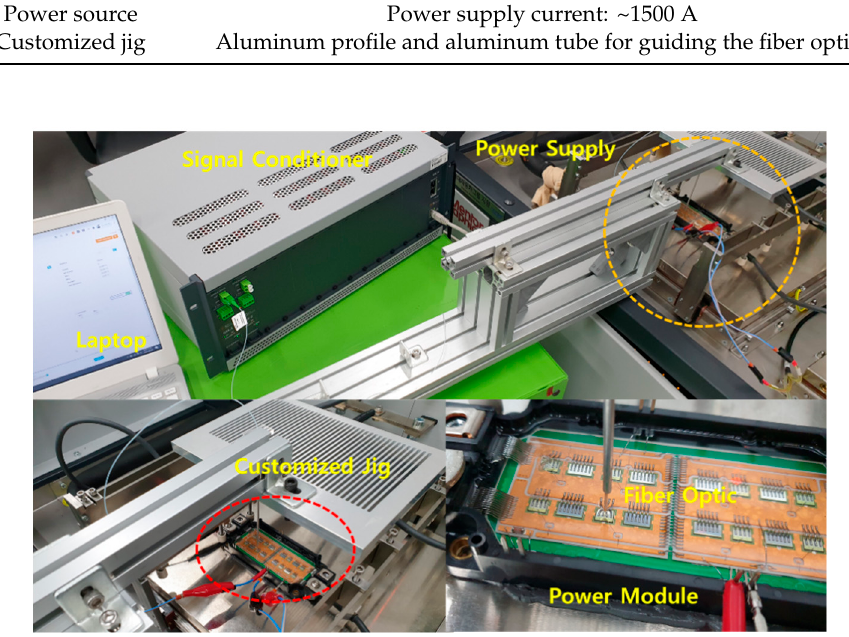
Figure 3. Experimental setup: fiber optic sensor, signal conditioner, power supply, and power module.